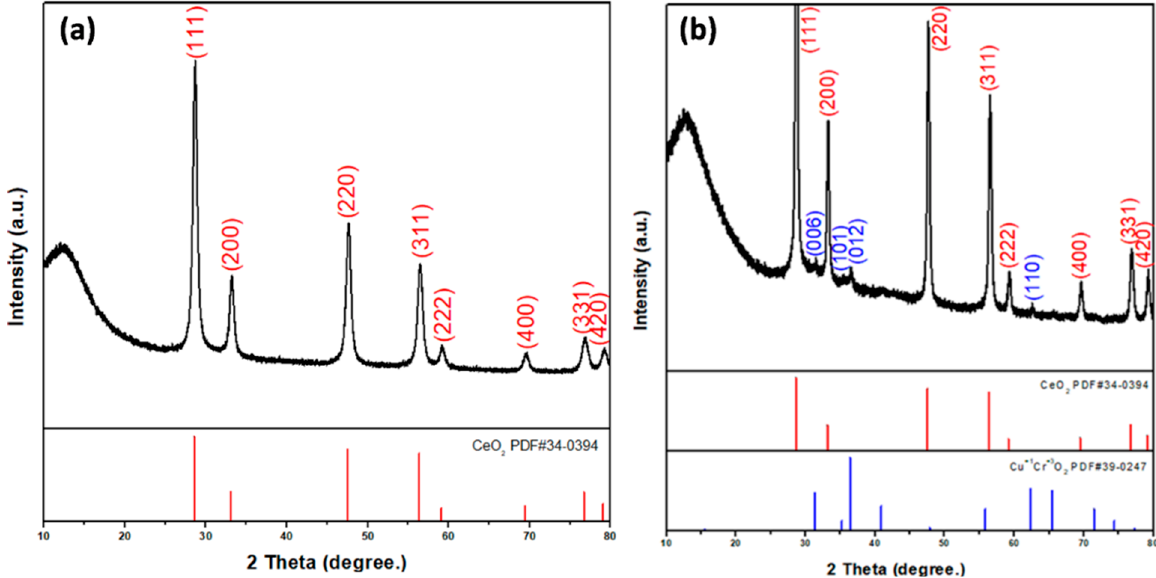
Figure 2. XRD patterns of ( a ) CeO 2 and ( b ) CeO 2 -CuCrO 2 nanofibers.